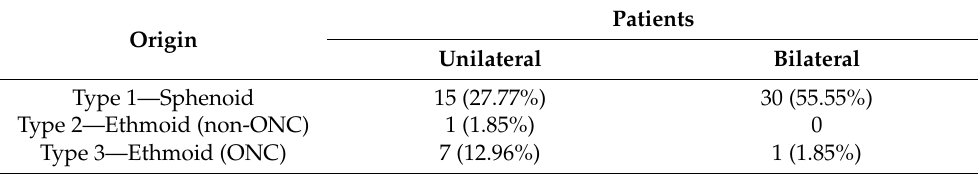
Table 1. Origin and prevalence of the pneumatization from the paranasal sinuses in optic strut. ONC—Onodi cell. N = 85